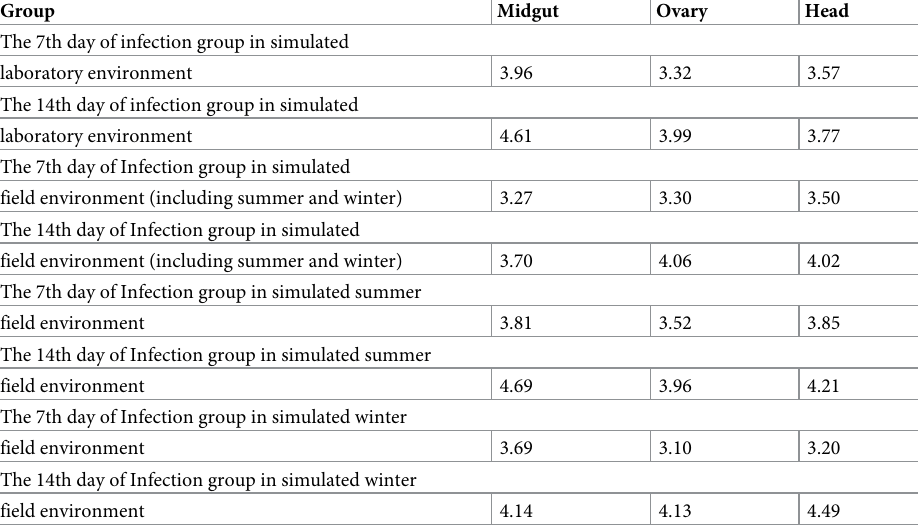
Table 6. Average copy number of dengue virus RNA in midgut, head and ovary of Ae . albopictus infected under different conditions.